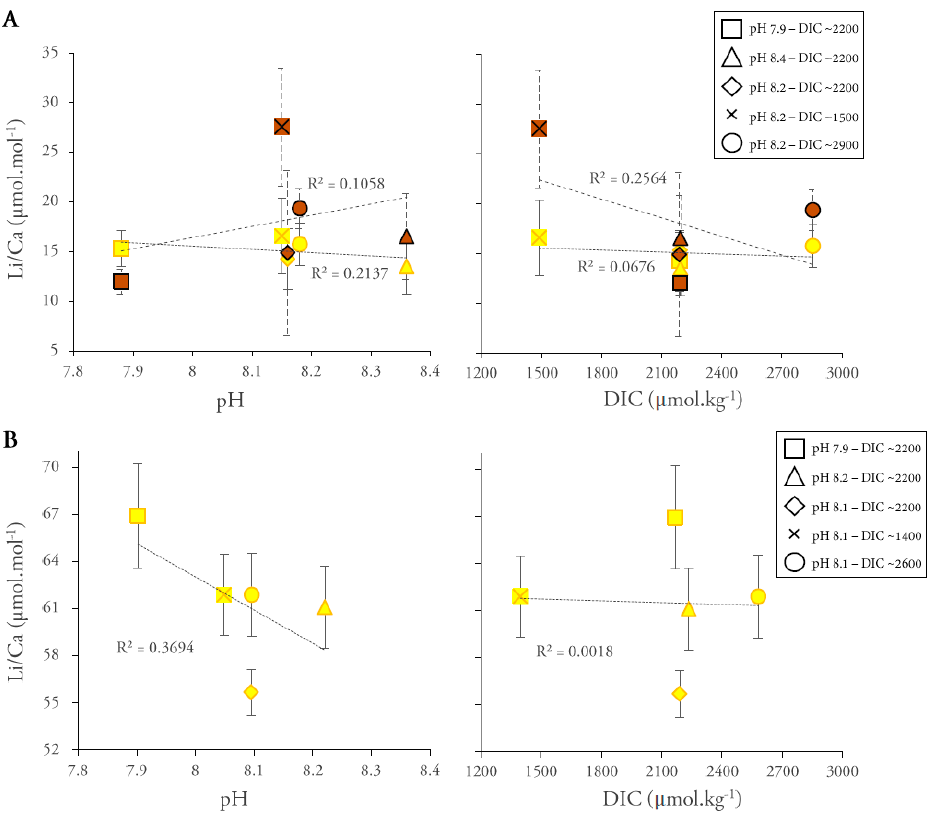
Figure 2. Li/Ca ratios in Amphistegina lessonii tests as a function of pH (left panel) and DIC (right panel). ( A ) Normal seawater; ( B ) ×5 Li-enriched seawater; note the different vertical scales. Yellow symbols—light/dark cycles. Brown symbols—dark only. The error bars for Li/Ca represent the external error (2 σ ). Errors for pH and DIC are negligible (and smaller than symbol size).